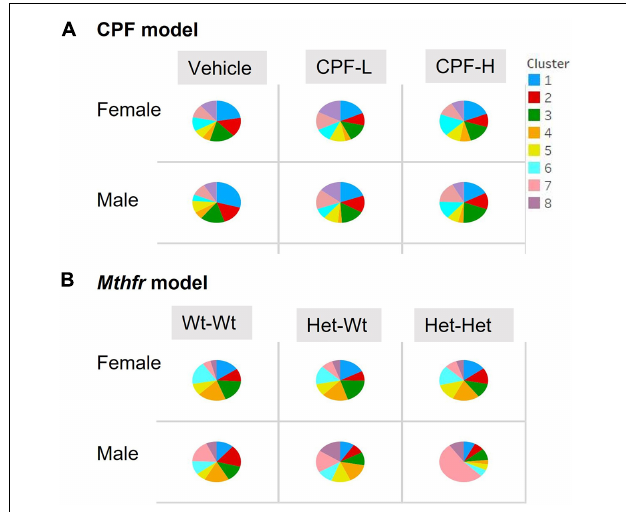
FIGURE 4 | CPF and Mthfr+/– altered the proportion of syllables per cluster emitted by the pups. The proportion of syllables emitted by each experimental group is presented for females and males: (A) CPF model and (B) Mthfr model. Different clusters are color coded as in Figure 4 . Note that each ASD model has a unique cluster distribution; the number and color code for Mthfr model do not overlap with the same characteristics in the CPF